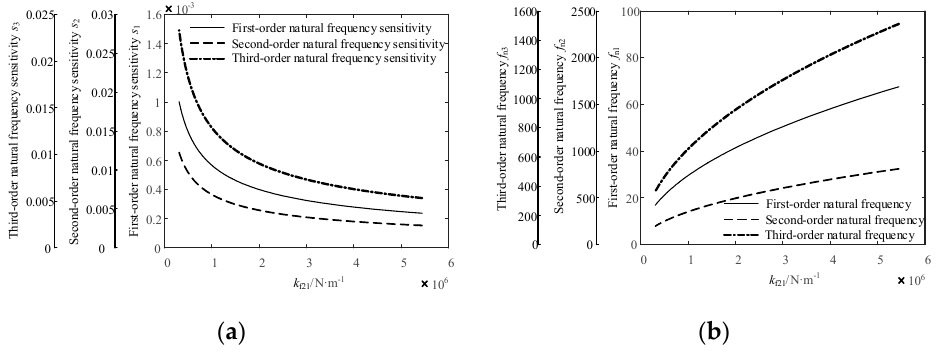
Figure 12. The variation law of the first three natural frequencies and their sensitivities of the jet system under a different initial gas content of fluid with the stiffness of fluid unit 2. ( a ) Variation law of natural frequency sensitivity. ( b ) Variation law of natural frequency.